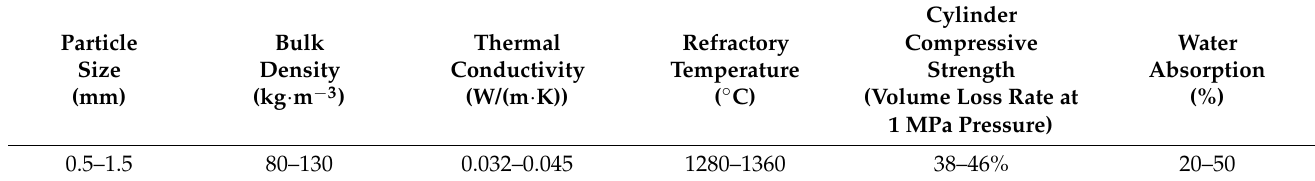
Table 2. The properties of